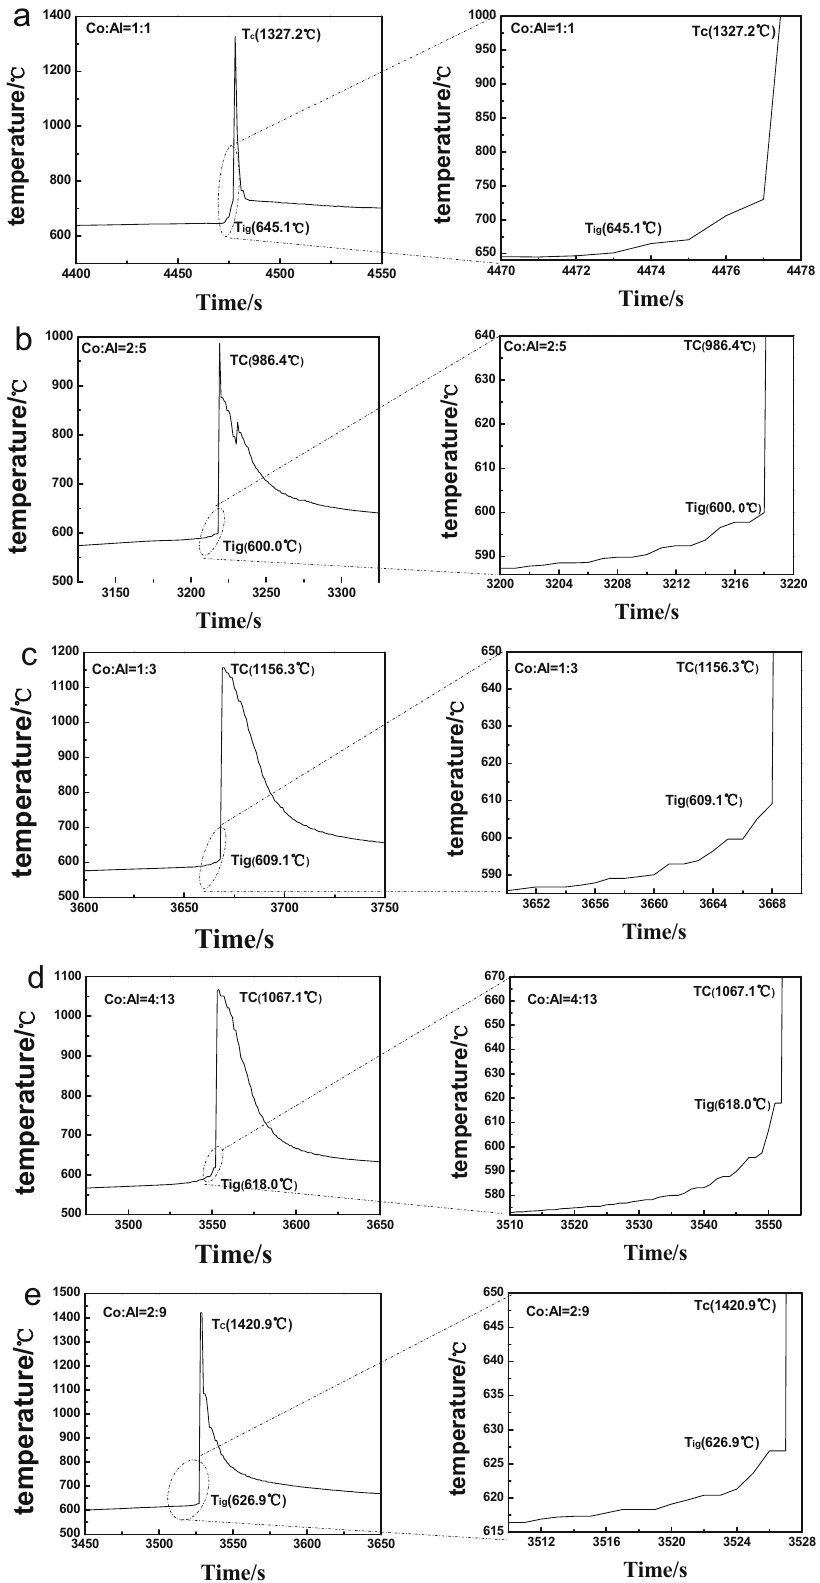
Figure 1: Temperature – time profiles ( left ) and magnified exothermic curves ( right ) with different Co/Al molar ratios: ( a ) 1:1, ( b ) 2:5, ( c ) 1:3, ( d ) 4:1, and ( e )